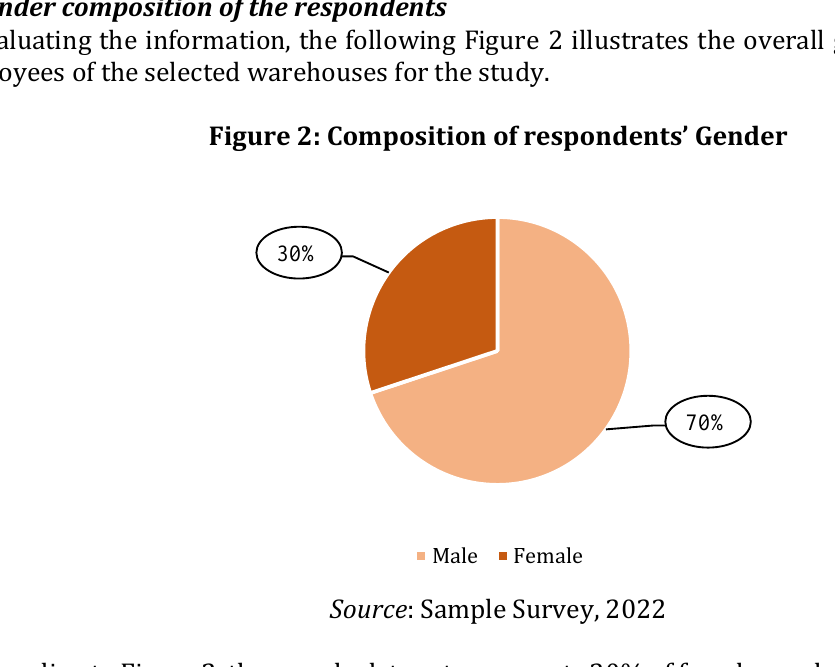
Source : Sample Survey,